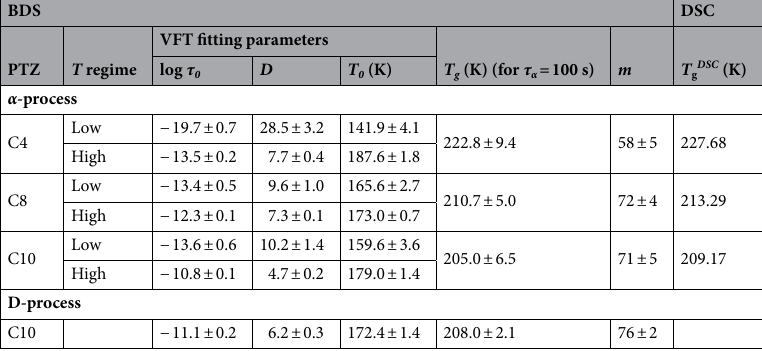
Table 1. The summary of the discussed parameters characterizing the dynamics of PTZ derivatives above T g : VFT fitting parameters (± standard error), glass transition temperatures and fragilities (± uncertainty value) calculated from VFT fit data, glass transition temperatures determined from